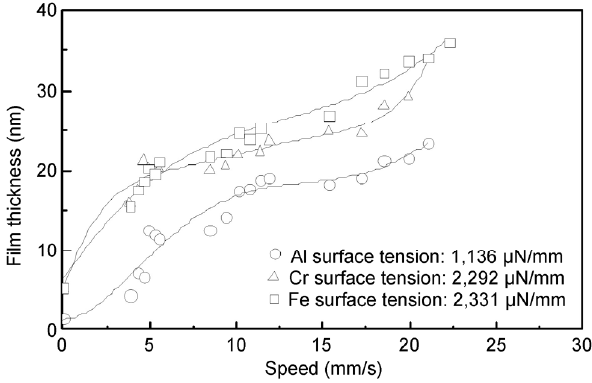
Fig. 17 Film formation of mineral oil on different substrate under a load of 4 N, measured by Luo et al. [4, 20].